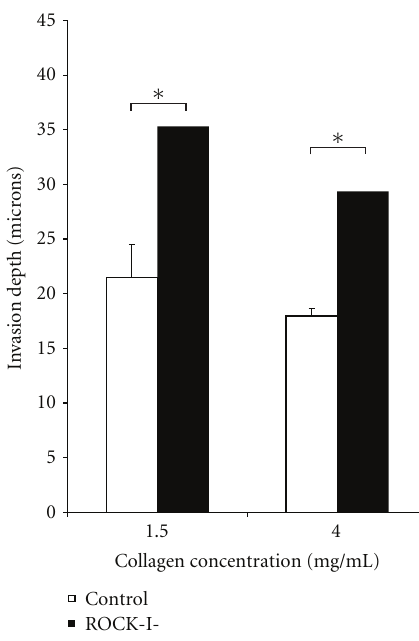
Figure 5: SW620 cells were seeded at densities of 50 × 10 3 and 250 × 10 3 cells/cm 2 onto 1.5 mg/mL collagen I gels. Sca ff olds were treated with Y-27632 to study the impact of ROCK-1 inhibition on cell proliferation in a low- and high-density environment. Treatment with Y-27632 resulted in a modest increase in cell proliferation for cells seeded at 50 × 10 3 cells/cm 2 and no significant change for those seeded at 250 × 10 3 cells/cm 2 . Furthermore, increasing cell density increased cell proliferation 2.5-fold for the untreated condition and 1.5-fold for those treated with Y-27632.